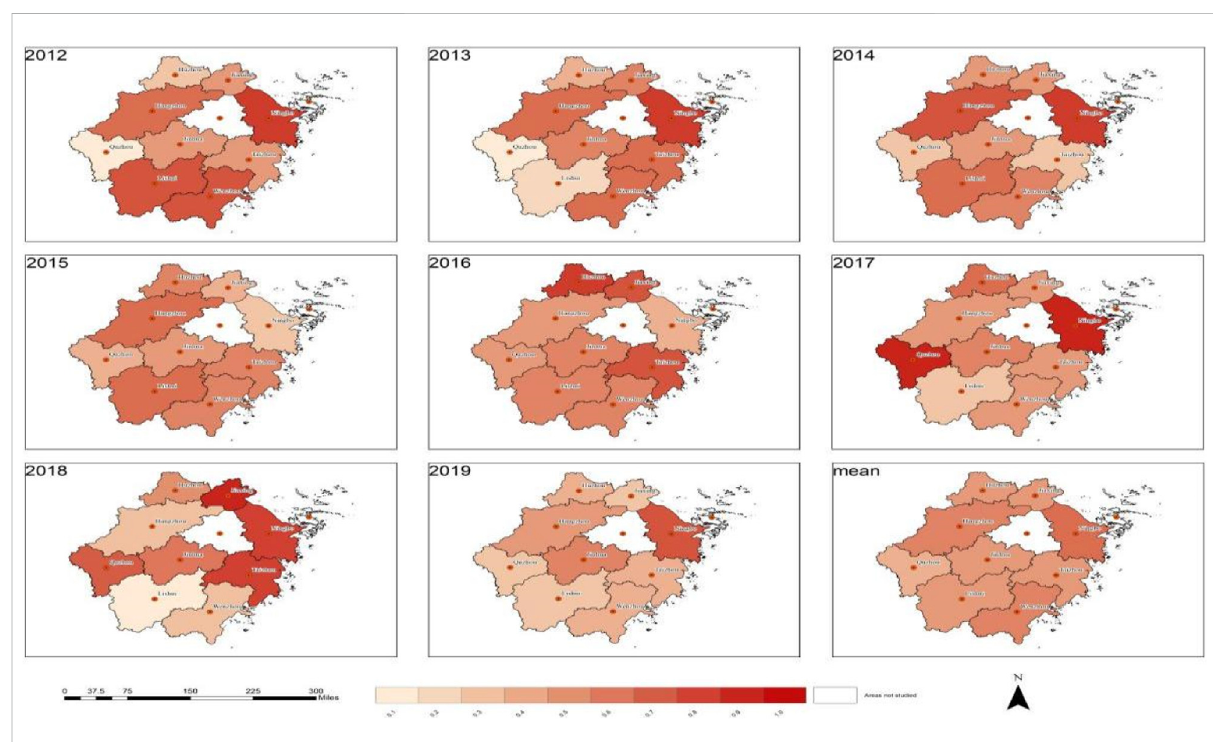
FIGURE 3 Spatial – temporal evolution of industrial technology innovation in nine cities in Zhejiang Province (2012 –